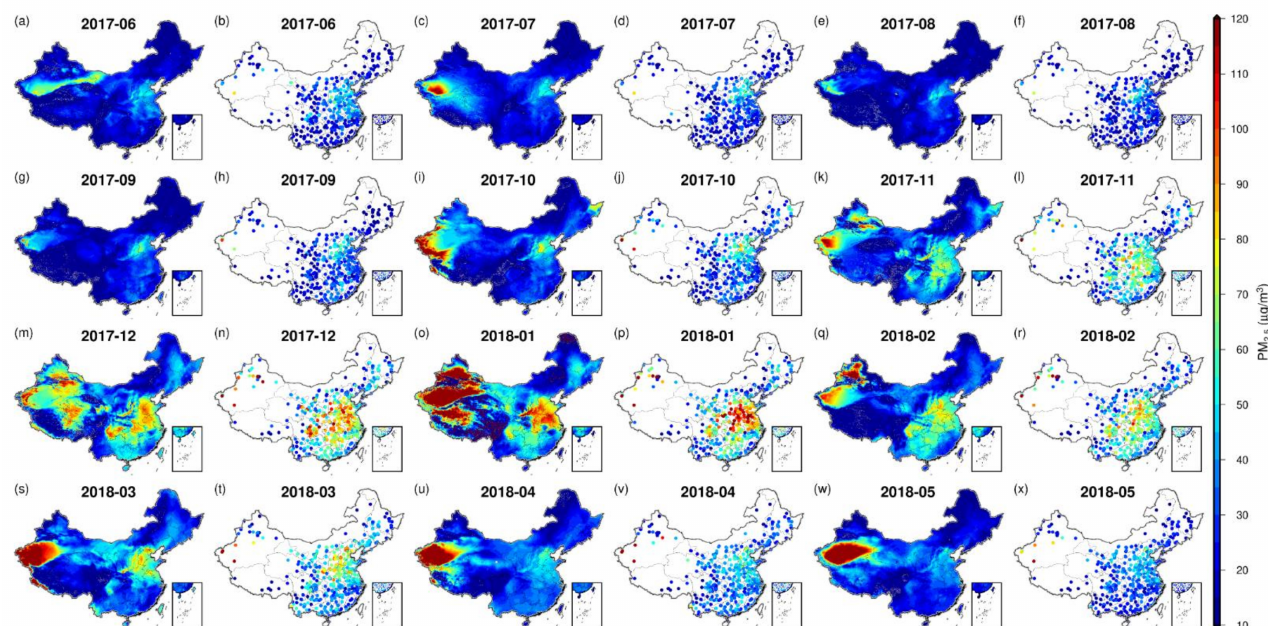
Figure 7. Spatial mappings of monthly satellite-estimated and ground-measured PM 2.5 concentrations in